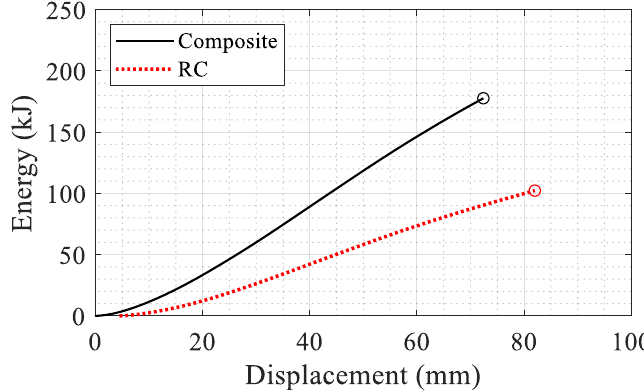
Figure 29. Comparison of residual axial capacity after blast damage between the two systems.